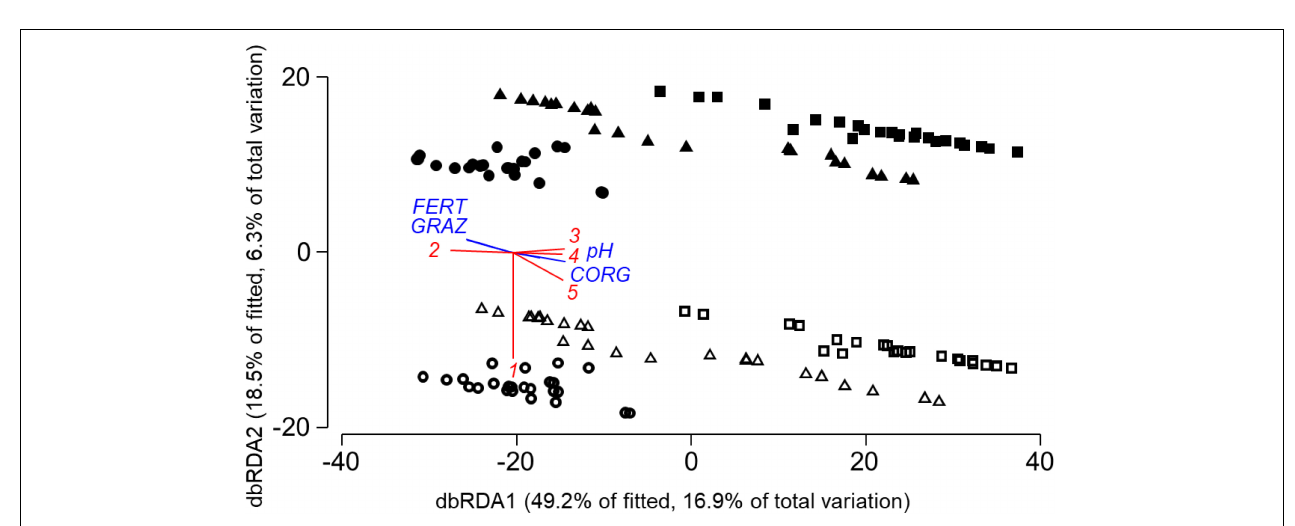
FIGURE 3 | Distance-based RDA plot of study plots based on oribatid mite community data and the model in Table 3C from AEG ( (cid:110) ), HEG ( (cid:108) ) and SEG ( (cid:115) ) with samples from spring (solid) and autumn (open) 2009. Individual predictor variables from selected indicator groups of the model in Table 3C are superimposed (CORG, soil organic carbon content; pH, soil pH value; GRAZ, average livestock density 2006–2008; FERT, average fertilizer amount 2006–2008). Oribatida species with correlation coefficients > 0.3 between axis scores of sites and abundances are also superimposed with (1) Malaconothrus monodactylus , (2) Tectocepheus velatus, (3) Eupelops acromios, (4) Achipteria coleoptrata, and (5) A. nitens .